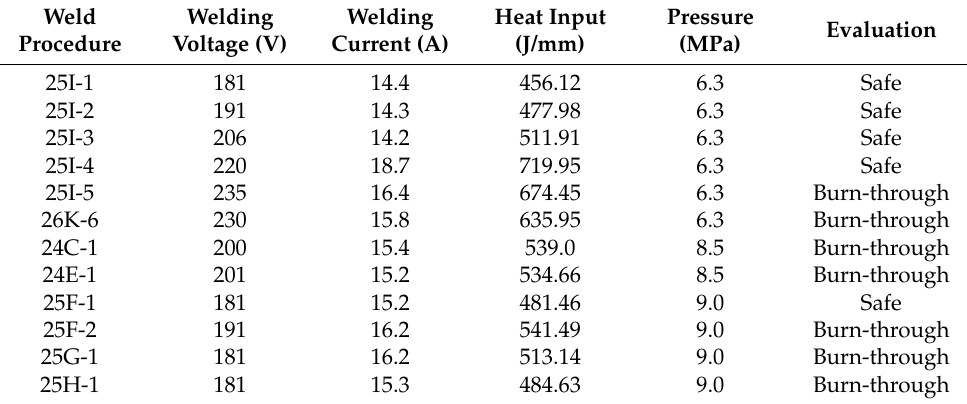
Table 3. Circumferential in-service welding observed with external observation set-up.